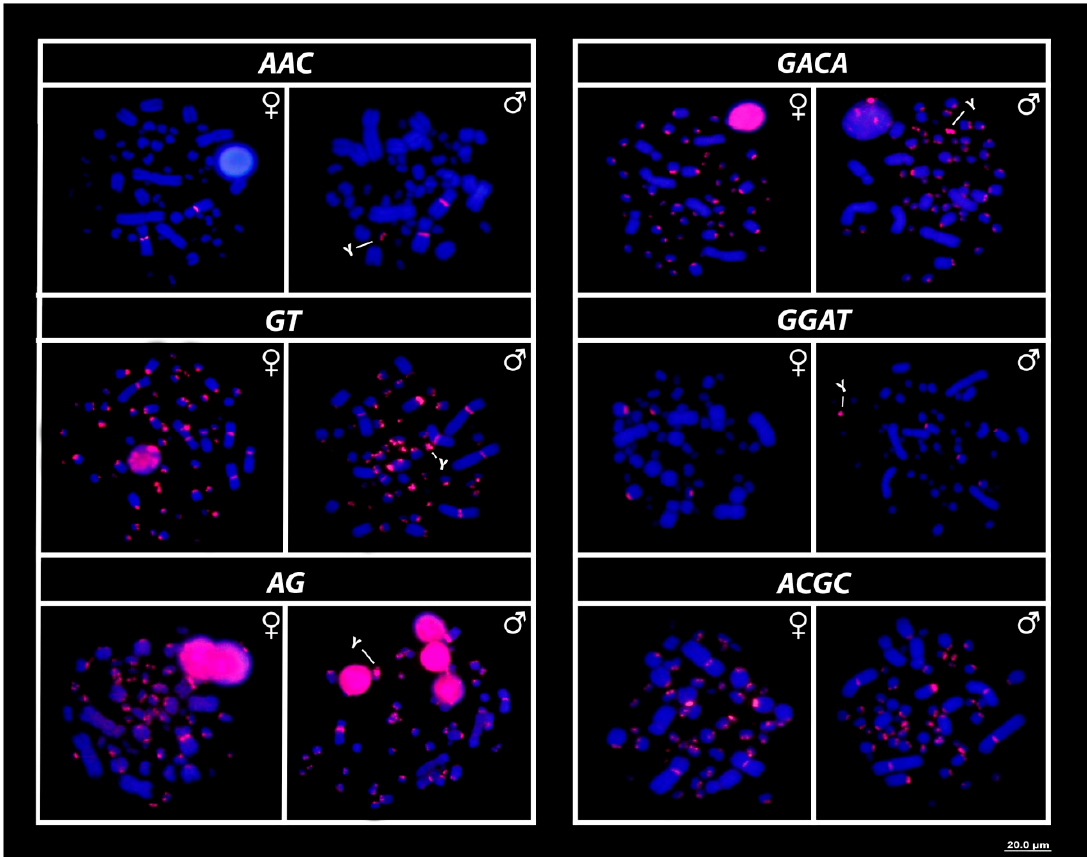
Figure 3. Mapping of several simple short repeats (SSRs) on the chromosomes of males and females of R. rufipes , with highlights to the particular accumulation for some of them on the micro Y sex chromosome (arrows). Bar = 20 µm.